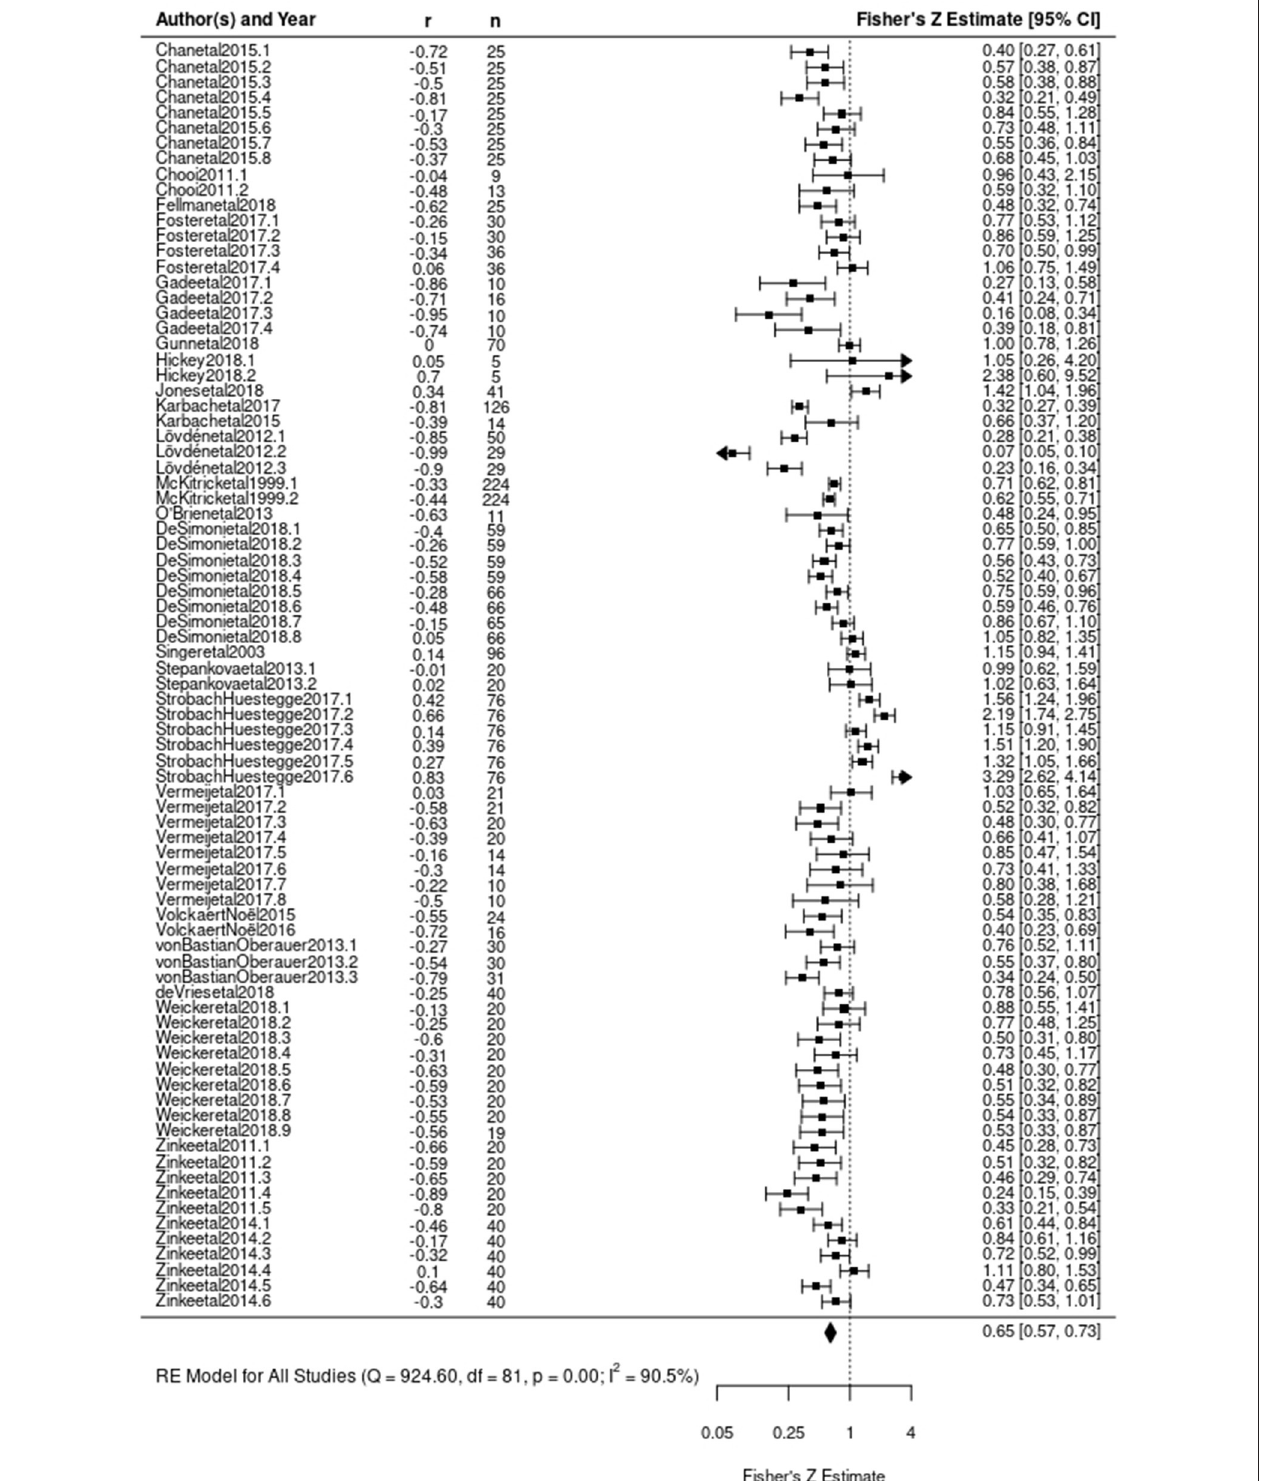
FIGURE 5 | Forest plot of Model 1 results. Each correlation coefficient is plotted according to its Fisher’s Z transformation. Size of square indicates weight assigned to the observation during analysis. Length of lines extending from square indicates variance associated with observation based on sample size. Each observation’s Fisher’s Z transformation and confidence interval are presented on the right. The diamond at the bottom indicates the estimated Fisher’s Z transformed correlation coefficient derived from Model 1.